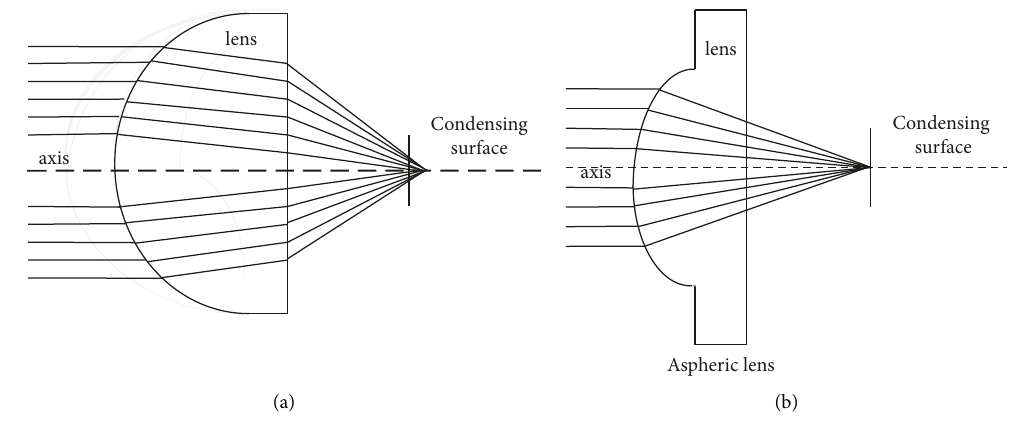
Figure 6: Spherical lens and aspherical